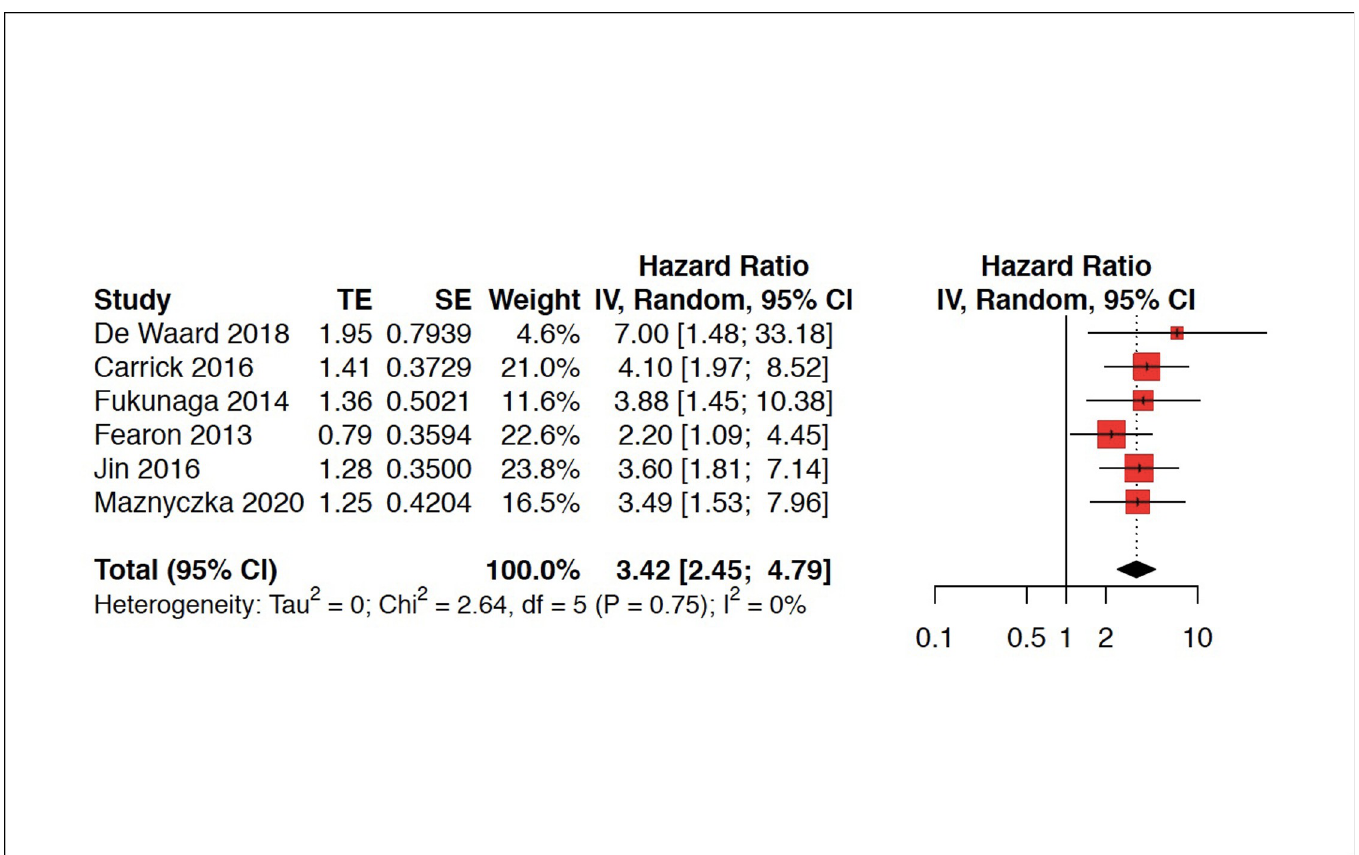
Fig 3. Forest plot of MACE with and without severe CMVD. CMVD was significantly associated with an increased risk of MACE, with a pooled HR of 3.42 [2.45; 4.79]. Squares and diamonds = hazard ratios, lines = 95% CI. TE = treatment effect; SE = standard errors; MACE = Major Adverse Cardiovascular Events; CMVD = coronary microvascular dysfunction; CI = confidence